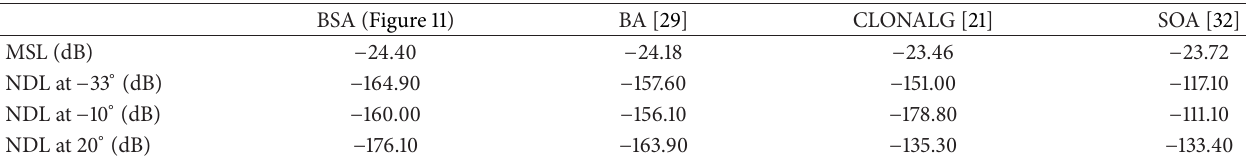
Table 5: MSL and NDL values obtained by BSA and other optimization techniques BA [29], CLONALG [21], and SOA [32] for triple null imposed at − 33 ∘ , − 10 ∘ , and 20 ∘ .